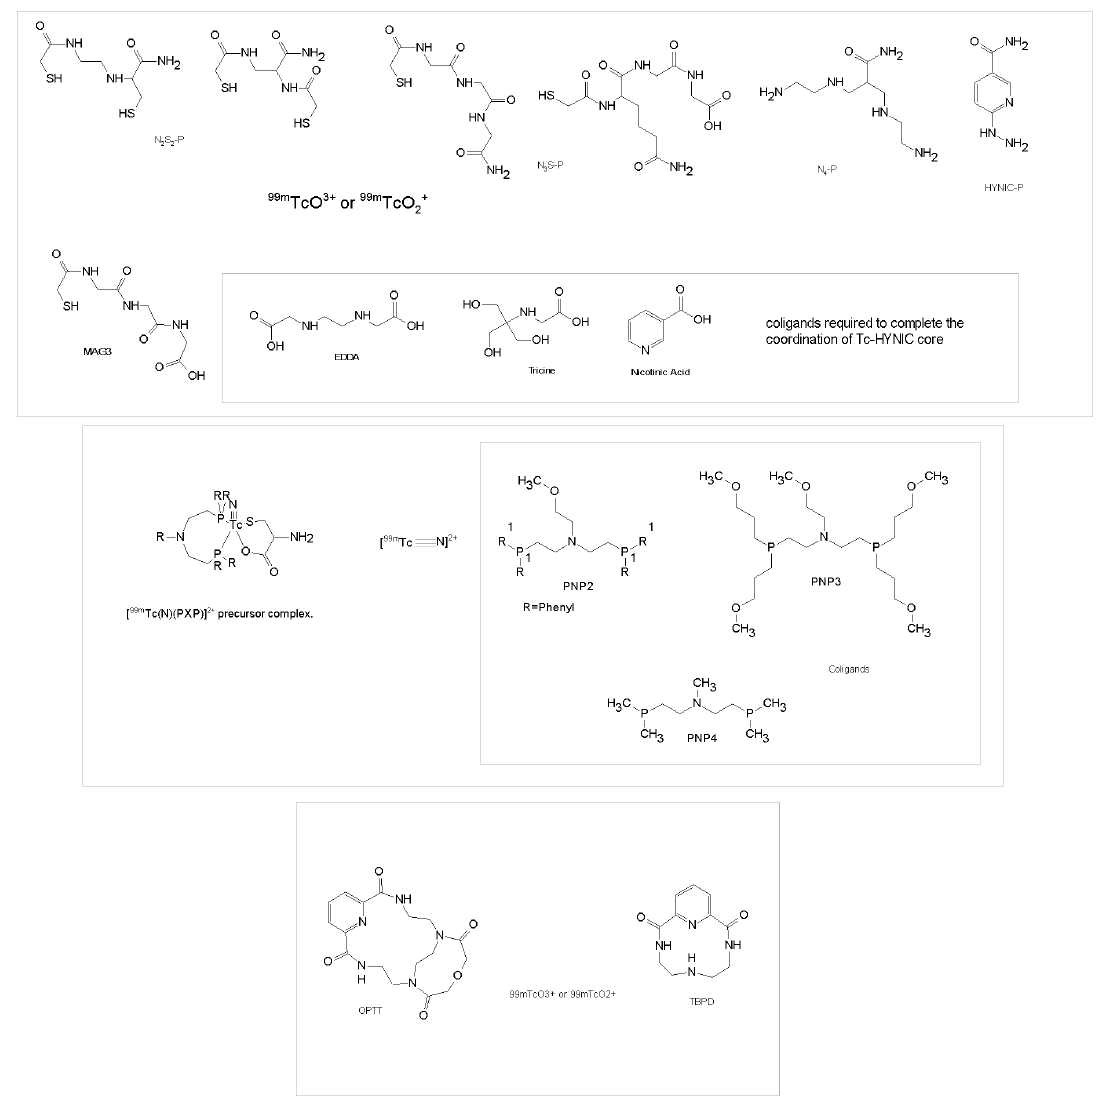
Figure 2. Schematic model illustrating 99m Tc chelators and co-ligands.